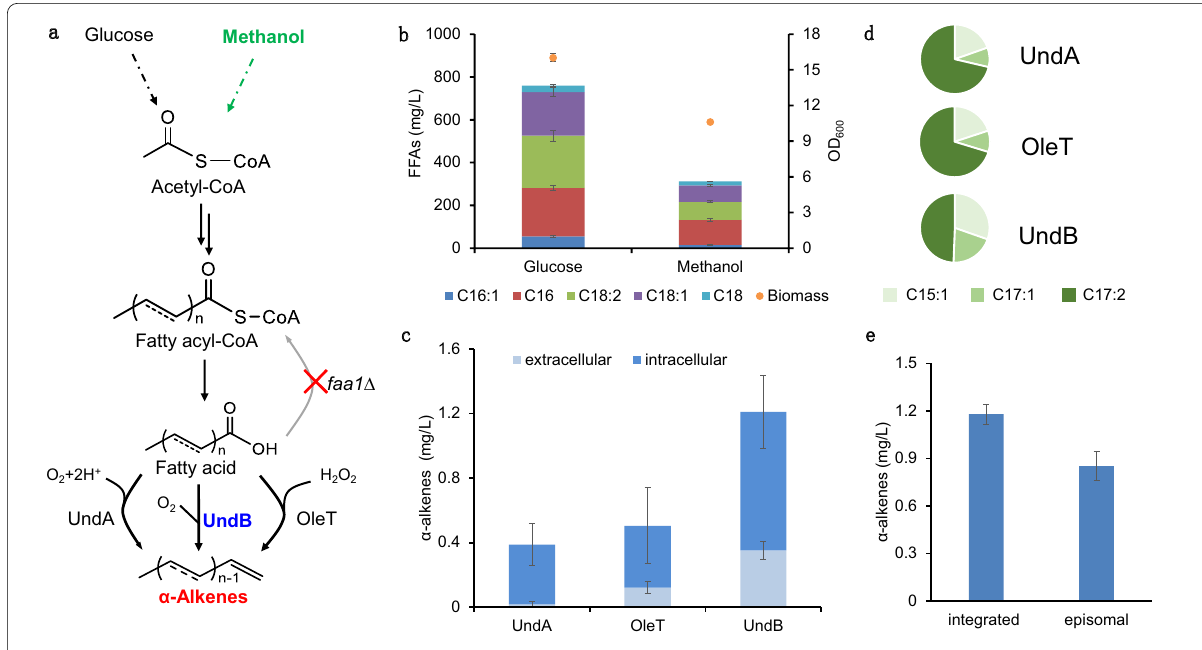
Fig. 1 Construction of α-alkenes biosynthetic pathway in P. pastoris . a Schematic illustration of metabolic pathways engineered for the production of α-alkenes from FFA via three pathways. b FFA titers of faa1 Δ strain in shake flask after 96 h cultivation in 20 g/L glucose medium or 120 h cultivation in 20 g/L methanol medium. c α-Alkenes production from three different decarboxylases in glucose medium. d α-Alkenes profiles of the engineered strain with expression of different decarboxylases in glucose medium. C15:1, 1-pentadecene; C17:1, 1-heptadecene; C17:2, 1,8-heptadecadiene. e Comparison of episomal expression and chromosome integration of UndB for α-alkenes production. All data were represented as the mean s.d. of three ±